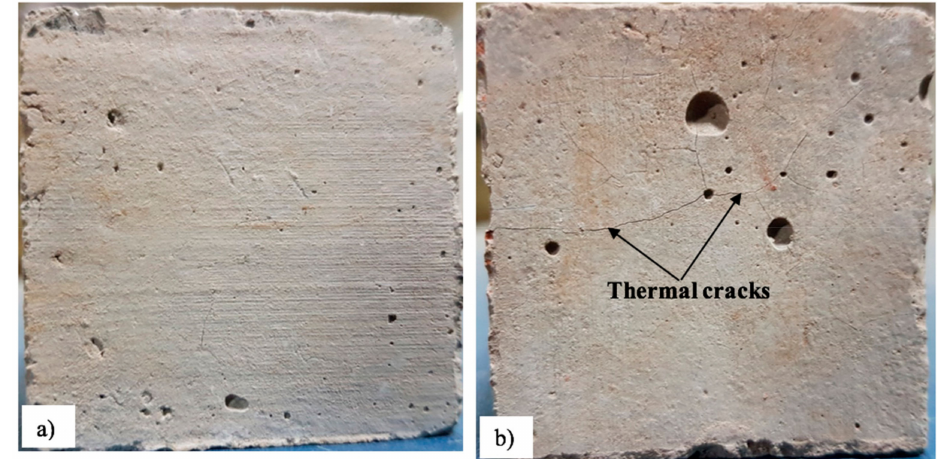
Figure 13. Images of mortars specimens subjected to 600 ◦ C: ( a ) reference mortar (0% RIP) and ( b ) mortar made with 50%